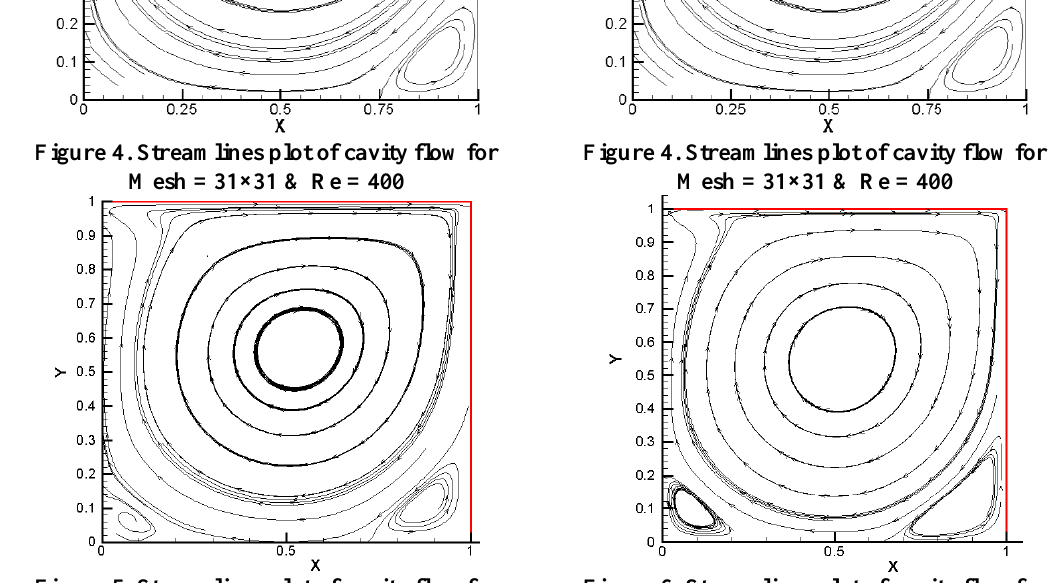
Figure 4. Streamlines plot of cavity flow for Mesh = 31×31 & Re = 400